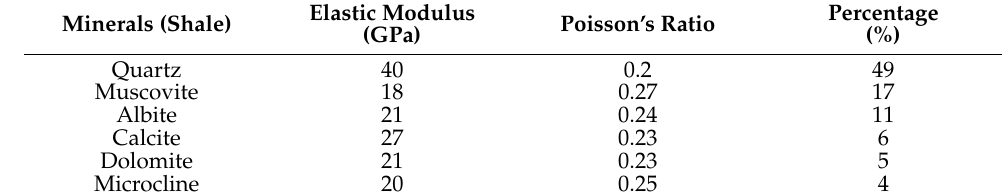
Table 1. Mineral parameters [24].